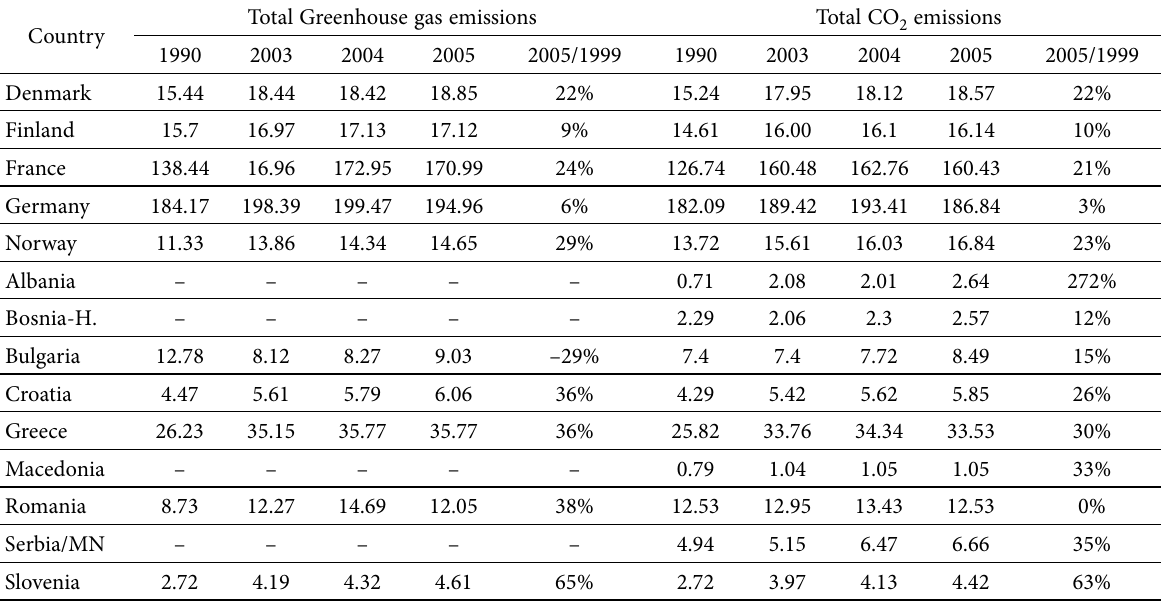
Table 3. Total greenhouse gas and CO 2 emissions from transport (million tonnes of CO 2 equivalent) Total Greenhouse gas Country